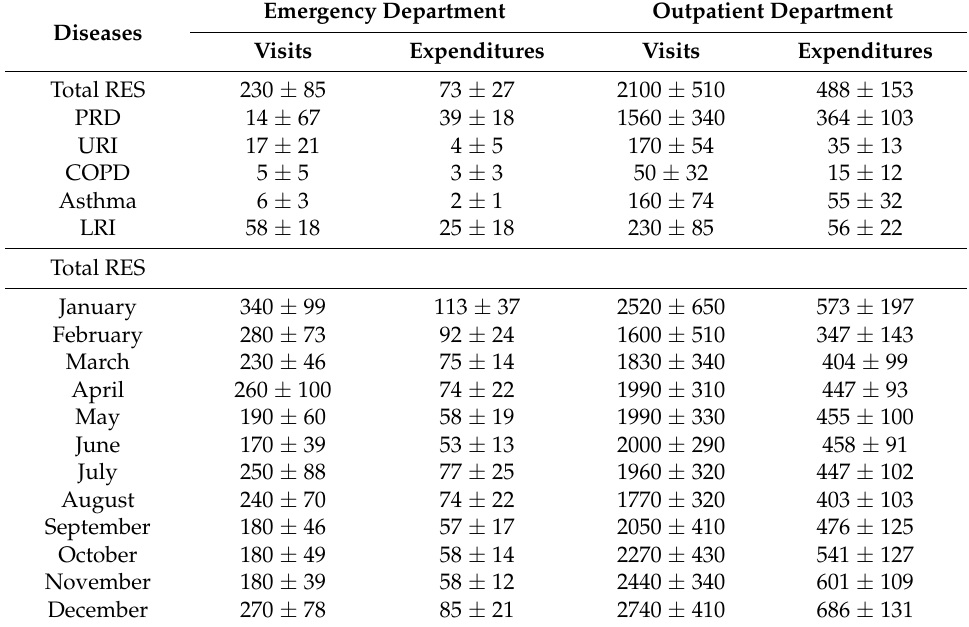
Table 2. The summary descriptive statistics (mean ± standard deviation) on daily visits and expenditures ( × thousand, CNY) for the emergency- and outpatient-department due to respiratory diseases in this study.